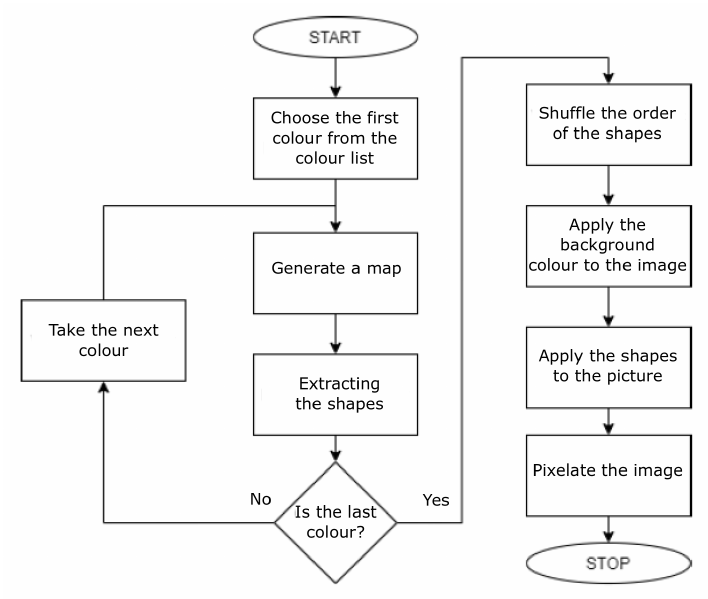
Figure 13. Simplified schema of camouflage generation